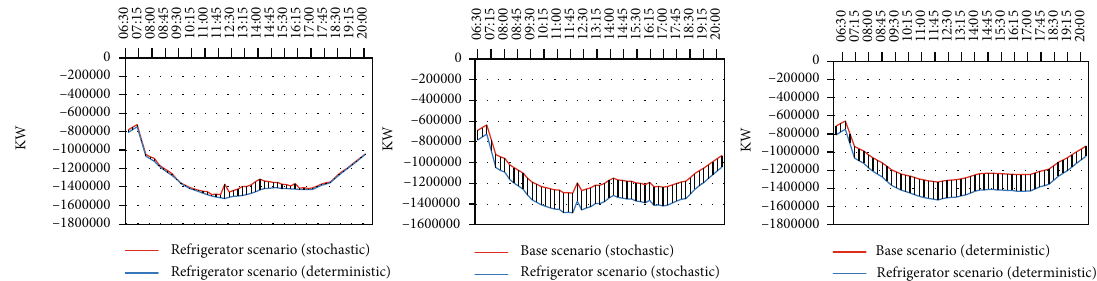
Figure 22: Di ff erent modes in the refrigerator scenario